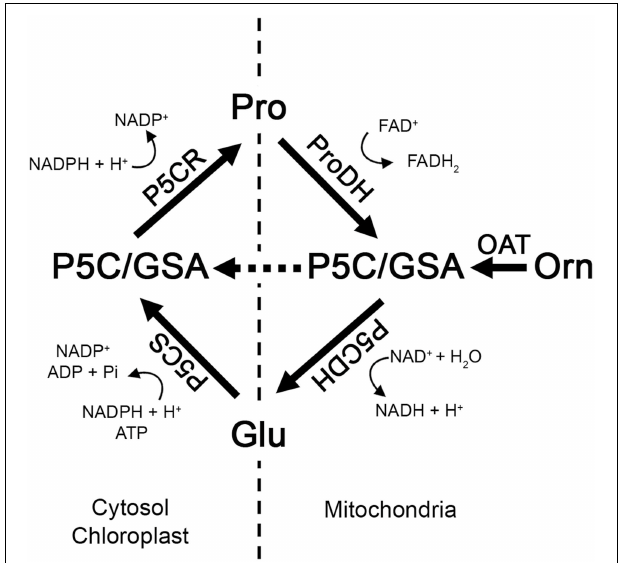
FIGURE 1 | Model of Pro metabolism in Arabidopsis. P5CS and P5CR synthesize Pro from Glu at cytosol and chloroplasts. ProDH and P5CDH oxidize Pro into Glu at mitochondria. OAT transfers the delta amino group from Orn to 2-oxoglutarate producing GSA/P5C and Glu. P5C acts as an intermediate of all these pathways. GSA, glutamate-semialdehyde; P5C, 1 1 pyrroline-5-carboxylate; P5CS, P5C synthase; P5CR, P5C reductase; ProDH, proline dehydrogenase; P5CDH, P5C dehydrogenase; OAT, ornithine δ -amino transferase.